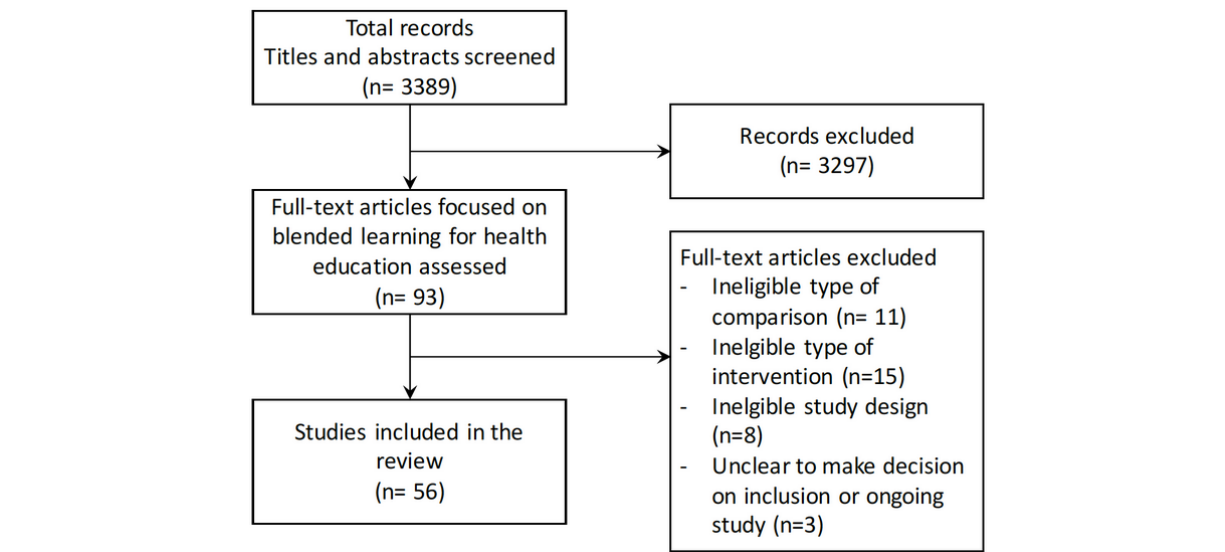
Figure 1. Study flow